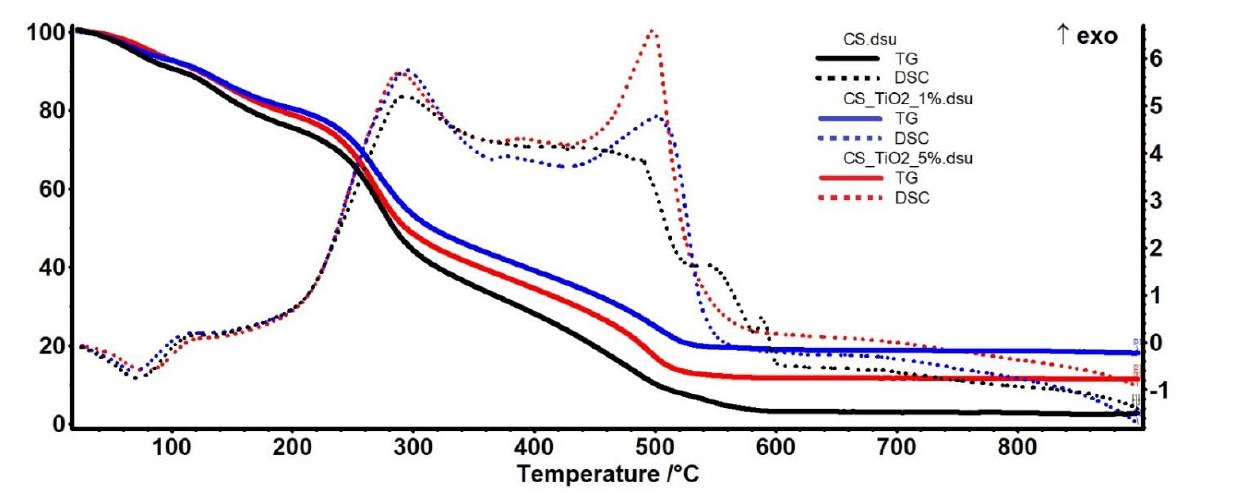
Table 2. Information regarding the TG/DSC analysis of chitosan/TiO 2 composite membranes.